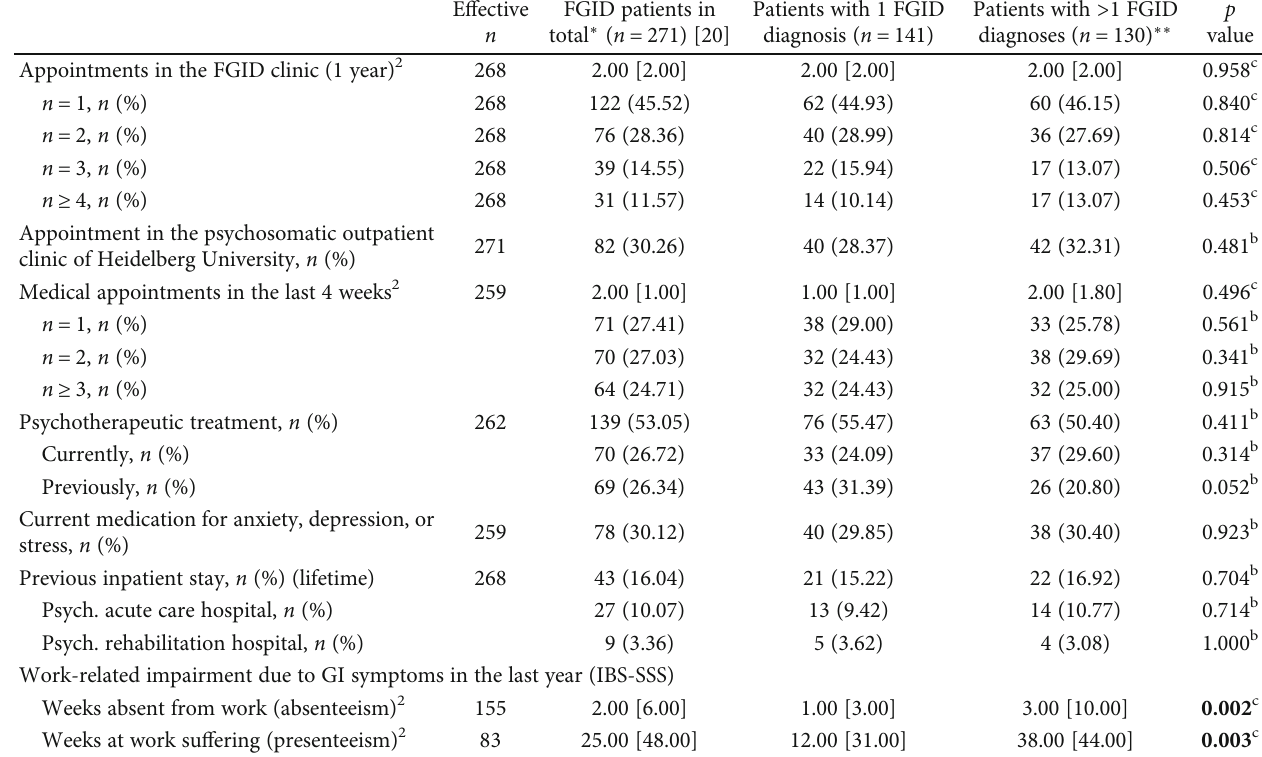
Table 3: Health care utilization and work-related